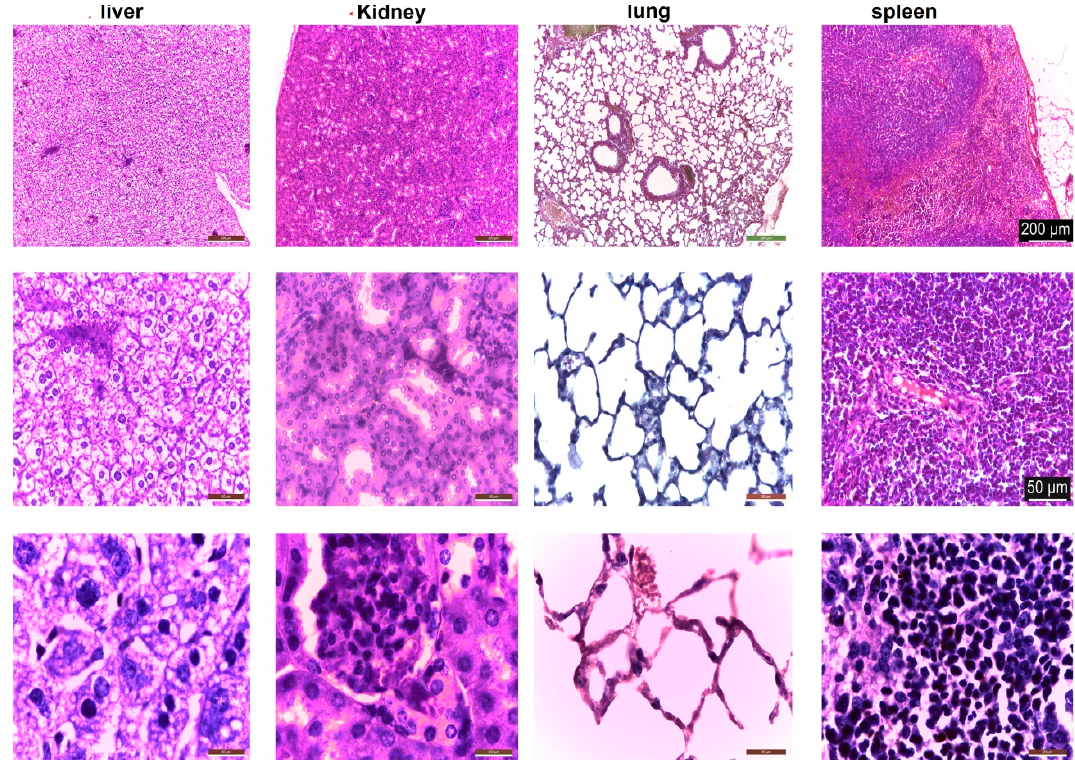
Figure 10. Histological structure of liver, kidney, lung, and spleen in control mice. HE staining. In the case of the experimental groups, by HE staining, no major changes in the histological structure of the organs studied were observed (Table 5). pending on the route of administration and dose. Administration p.o. and s.c., irrespective Table 5. Assessment of cellular and vascular changes produced in the organs under study. of dose, caused ectasia of a small number of veins in the liver (Figure 11), kidney (Figure 12), lung (Figure 13), and spleen (Figure 14). In the liver the hepatocytes show microvesicles and an increase in the number of Kupffer cells (6–7.5/12,879.8 mm 2 ). In the lung there is a high number of alveolar macrophages residing in the septal wall (14–24/12,879.8 mm 2 ). The alveoli have an intact, thin septal wall, but in some places it is thickened by macrophages. In the kidneys, the proximal convoluted tubules show rare brush border changes, and a small number of Malpighian corpuscles have a condensed glomerulus and increased capsular space volume (one in each preparation examined). In the interstitial space of the urinary tubules in the cortical area macrophages are observed (2–5/12,879.8 mm 2 ). In the spleen the lymphoid follicles show a slight increase, where pigments and megakaryocytes, some of them giant, appear.